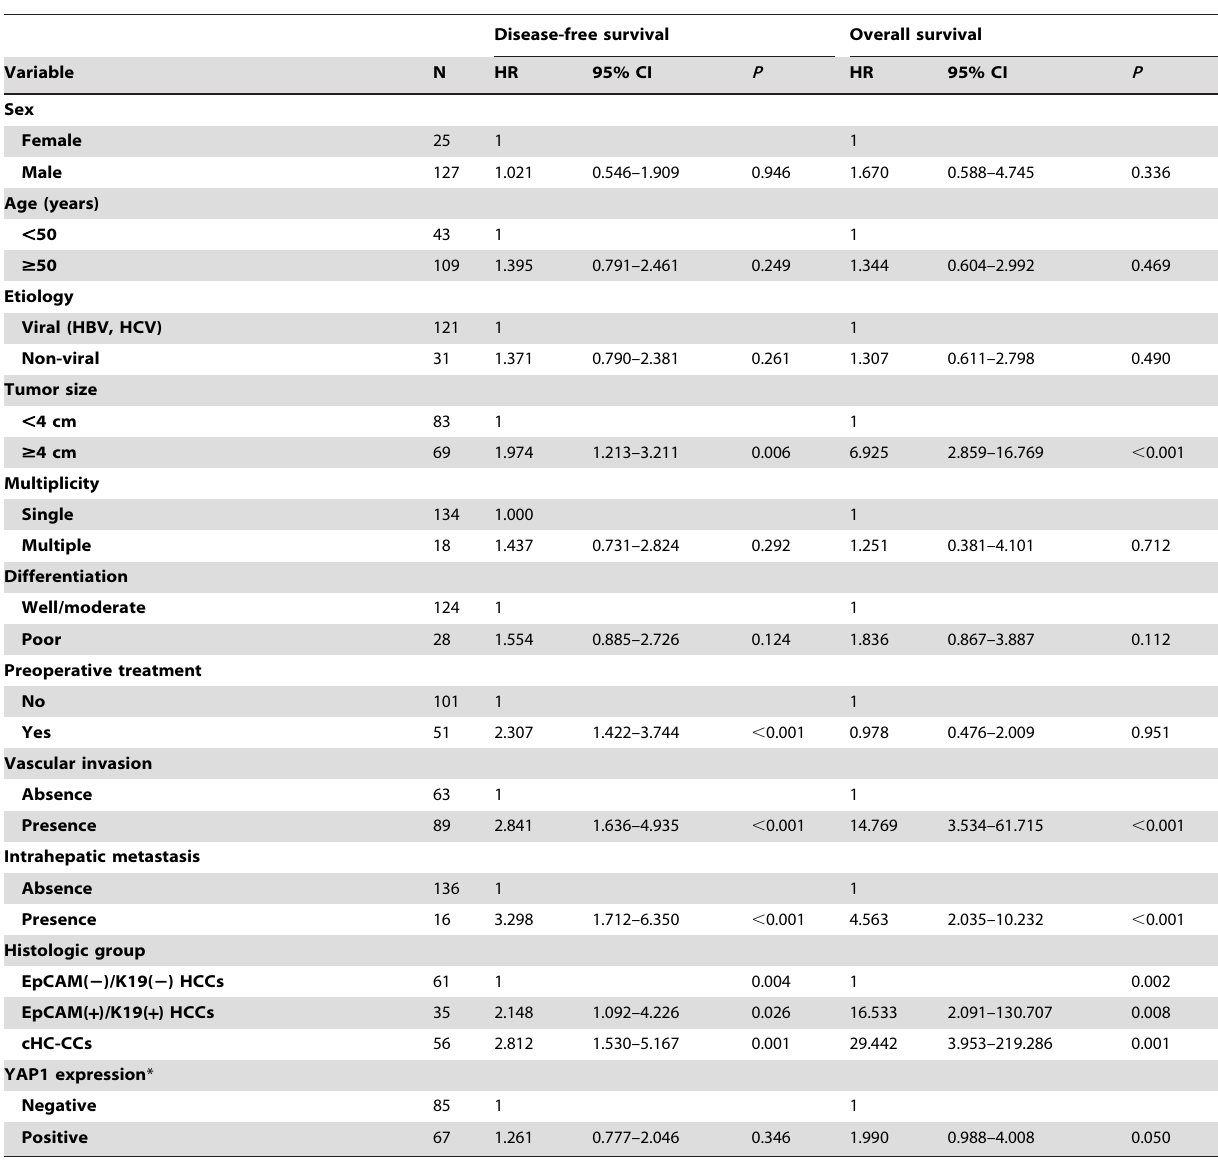
Table 4. Univariate analysis of disease-free and overall survival